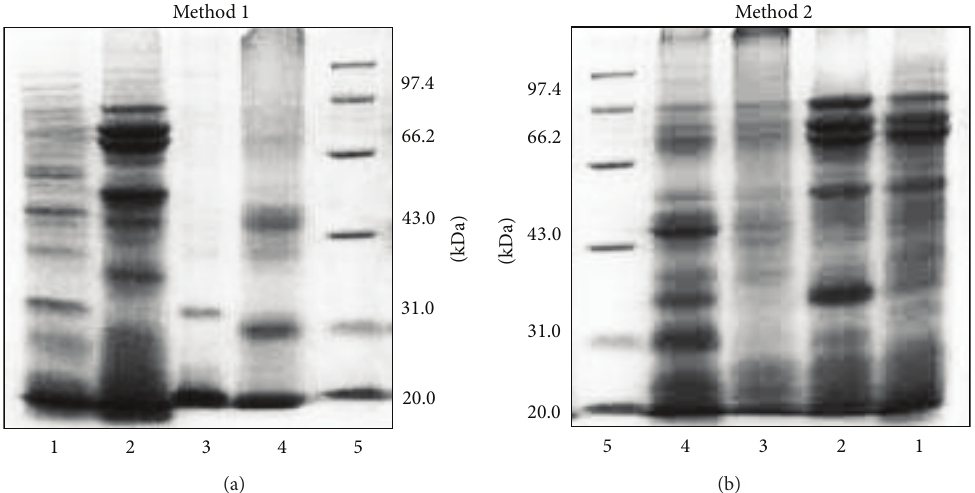
Figure 1: SDS-PAGE pattern of FRBP obtained by the two extraction methods. Lanes 1–5: albumin, globulin, prolamin, glutelin, and marker,